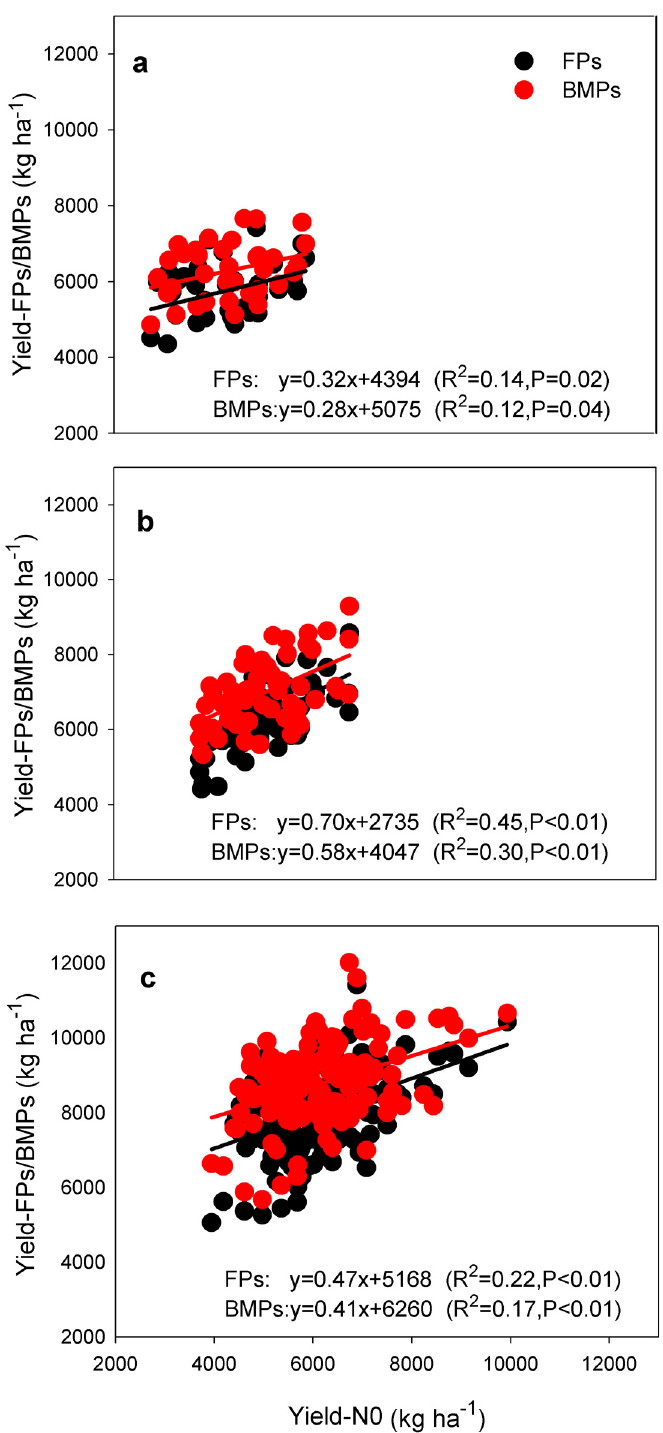
Fig 1. Relationships among management practices, soil inherent productivity and yield. Note: soil inherent productivity was estimated as yields in zero-N plots (Yield-N0). Black points represent farming practice (FPs); red points represent best management practice (BMPs). a, early rice (n = 98); b, late rice (n = 148); c, single rice (n = 157).